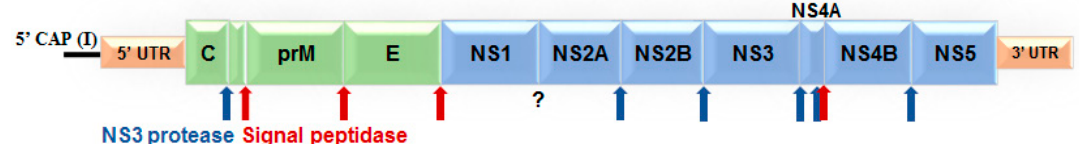
Figure 1. Zika virus genome. The viral genome comprises of a positive sense RNA that encodes a polyprotein that is processed by viral and host cell proteases. The amino terminus of the genome encodes the structural proteins (C-prM-E) essential for virion morphogenesis. The non-structural proteins NS1–NS5 are important for virus replication, polyprotein processing and invoking a cell mediated immune response, along with immune evasion.